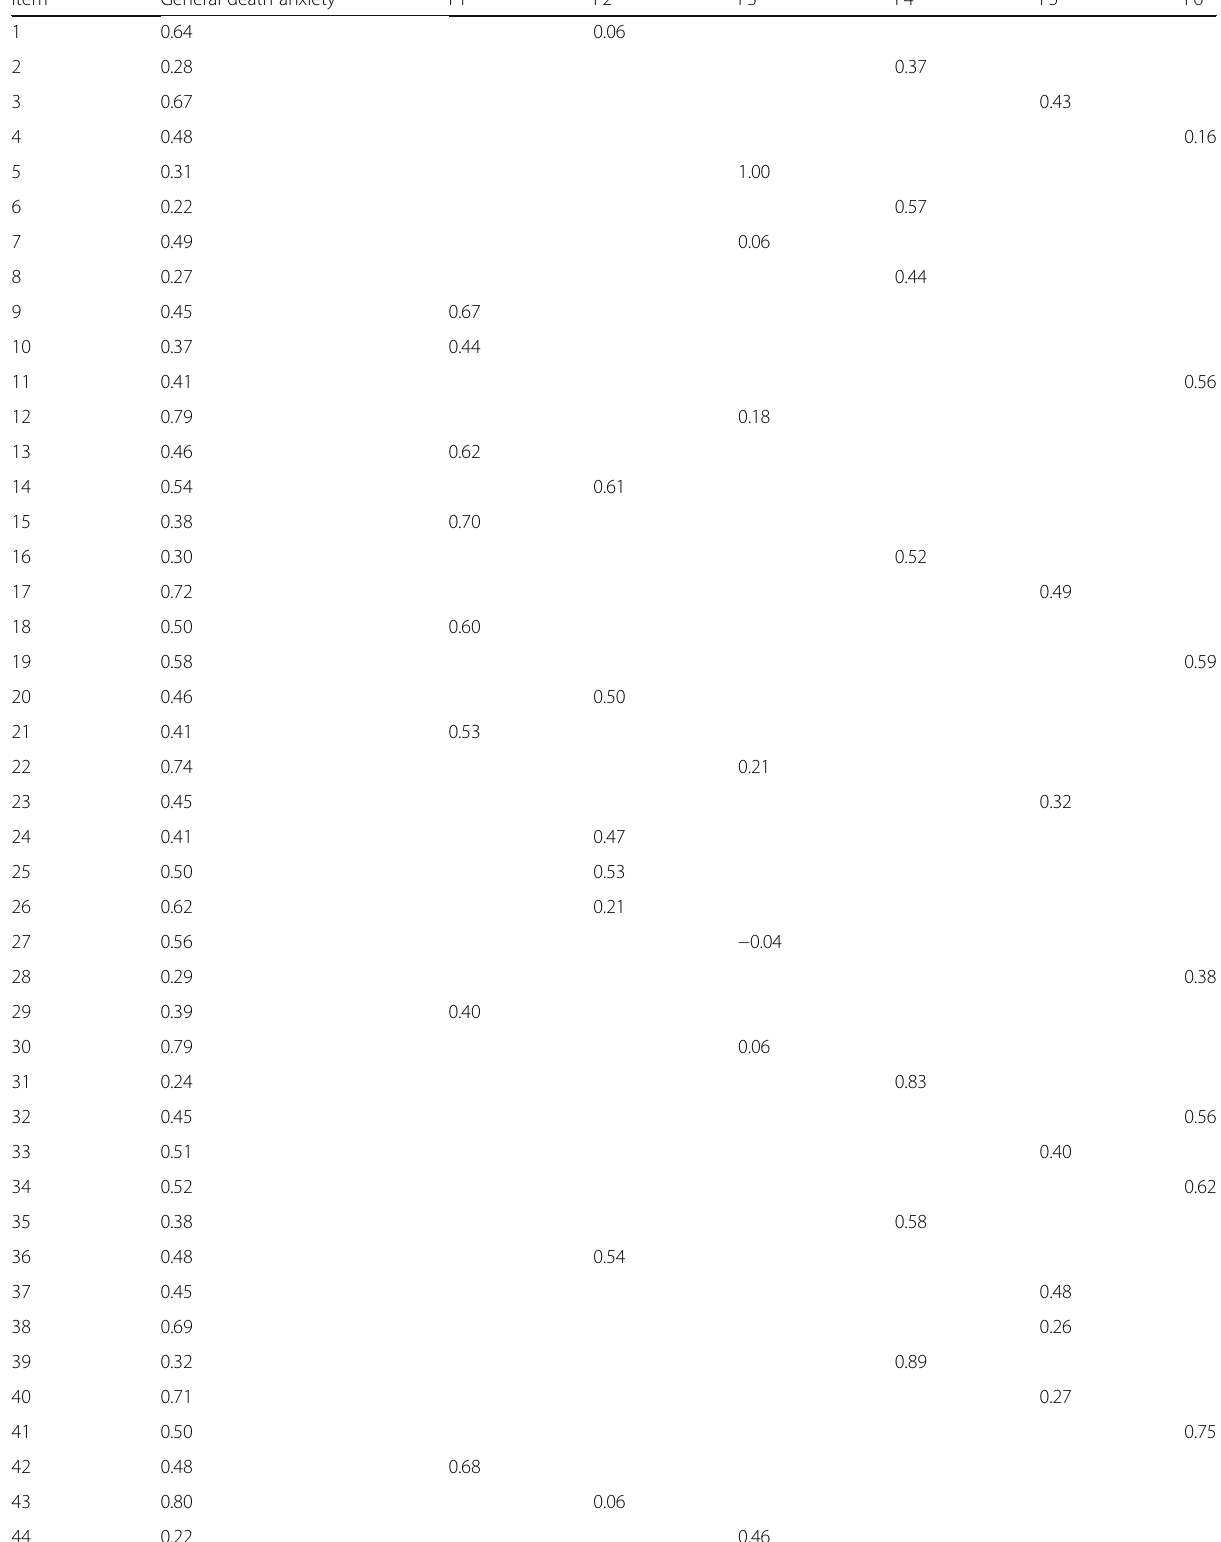
Table 1 Standardised factor loadings from the bi-factor model of the